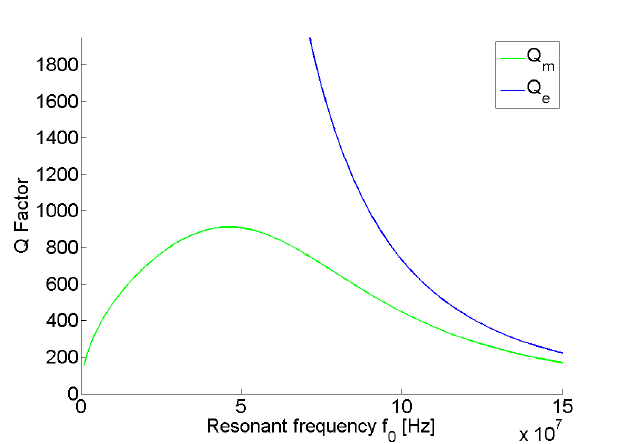
Figure 9. Variation in Q